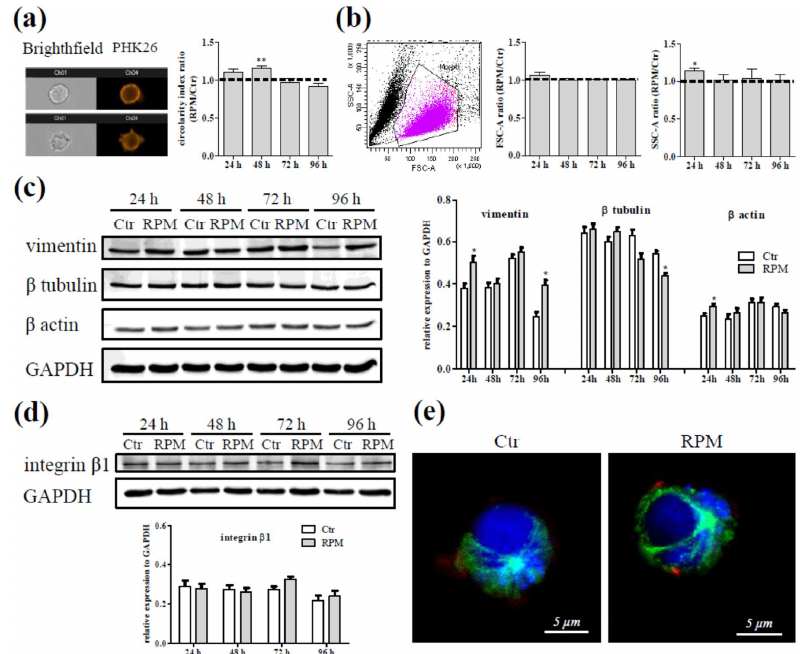
Figure 1. Effect of s-microgravity on cell shape and morphology. ( a ) Representative bright field and fluorescence images of a cell with high (left up) and low (left down) circularity index. The graph on the right shows the ratio between the circularity index of cells exposed to s-microgravity (random positioning machine (RPM)) and that of the corresponding controls (Ctr), for 24, 48, 72 and 96 h. ( b ) A representative forward and side scatter area (forward scatter (FSC)-A and side scatter (SSC)-A respectively) dot-plot, the values from dot-plot analyses of Ctr or RPM-exposed cells at 24, 48, 72 and 96 h, are collected on graphs and reported as the ratio between the mean of FSC-A or SSC-A at RPM conditions and the corresponding controls at each time point. ( c – d ) Representative immunoblots of vimentin, β tubulin, β actin and integrin β1 expression levels and densitometric analyses. In particular, the representative blots of β tubulin, β actin and glyceraldehyde-3-phosphate dehydrogenase (GAPDH) ( c ) were cropped from the same membrane, the immunoblot of vimentin ( c ) from a different membrane, that of integrin β1 and GAPDH ( d ) from another membrane. The densitometric analyses are plotted as relative expression calculated by the ratio between OD × mm 2 of each band and OD × mm 2 of the corresponding band of the GAPDH, considered as loading control, probed on the same membrane. The relevant proteins were detected using chemiluminescence kits (Pierce EuroClone S.p.A., Pero, Italy) and the signals were acquired and analysed using an image acquisition system (Uvitec mod Alliance9.7, Uvitec, Cambridge, UK), densitometric data were plotted using the Prism5 software (GraphPad, San Diego, CA, USA). In the densitometric analyses, data are means ± SEM from three independent experiments. ( e ) Representative images of Ctr or RPM cells stained with anti-tubulin (green fluorescence), phalloidin-Alexa 594 (red fluorescence) and Draq5 (blue fluorescence). Values of the histograms in a, b, c, and d are presented as means ±SEM, n = 3. * p < 0.05 compared with the corresponding Ctr.